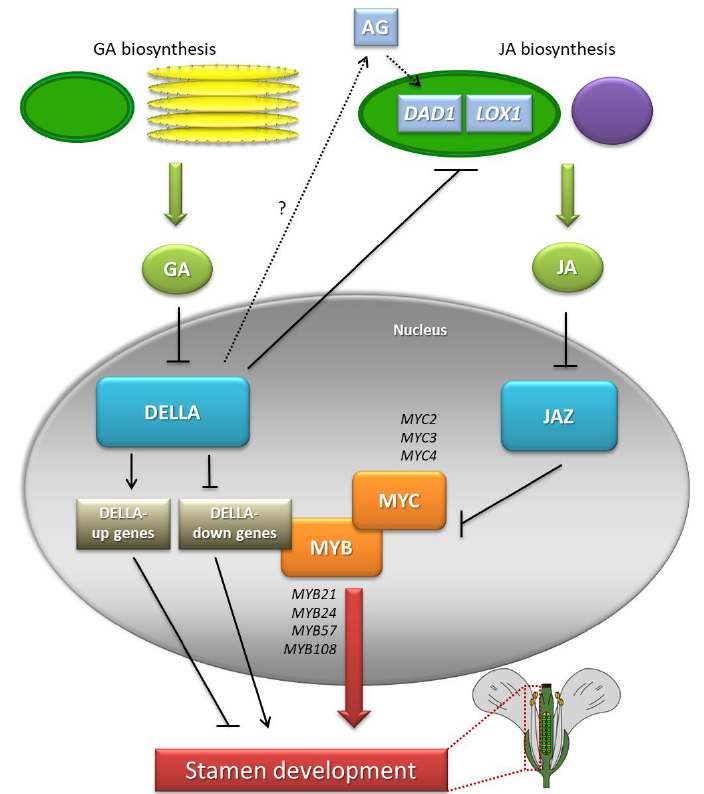
Figure 6. Interactions between GAs and JAs during stamen development in A. thaliana . GAs trigger the degradation of DELLAs to increase the expression of JA biosynthesis genes DEFECTIVE IN ANTHER DEHISCENCE1 ( DAD1 ) and LIPOXYGENASE1 ( LOX1 ), which promotes JA production. Degradation of JA ZIM-domain (JAZ) repressor induces the transcriptional activity of MYC and MYB genes (DELLA-down genes) for proper stamen development. GAs also act via a JA-independent pathway mediated by unknown GA‐response factors. According to [46,75,94].